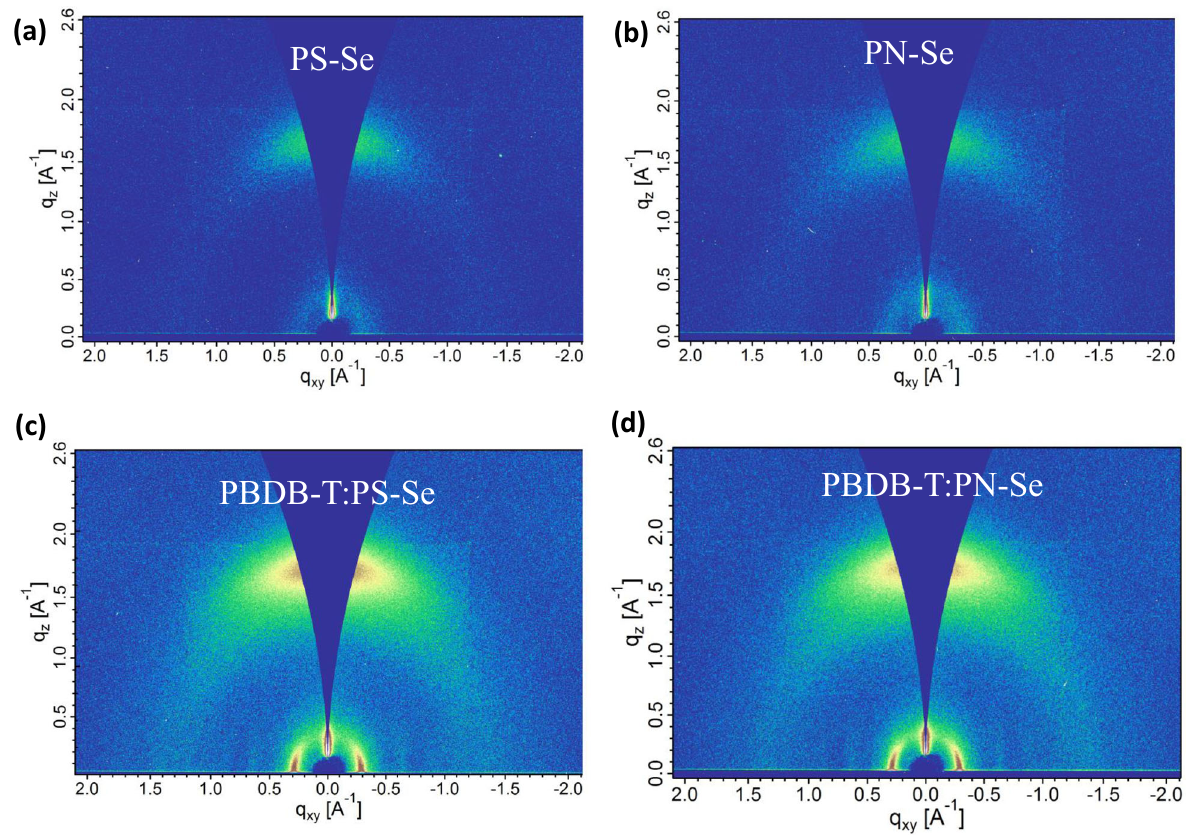
Fig. 5 2D-GIWAXS scattering patterns. 2D-GIWAXS scattering patterns of PS-Se and PN-Se neat fi lms ( a , b ), and their blend fi lms ( c , d ) with polymer donor